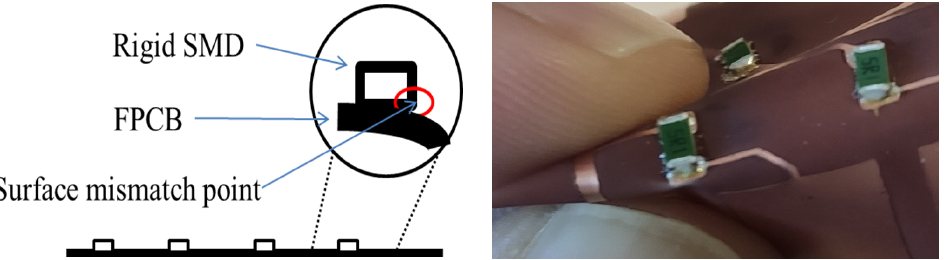
Figure 12. Flexibility mismatch problem between FPCB and SMD.